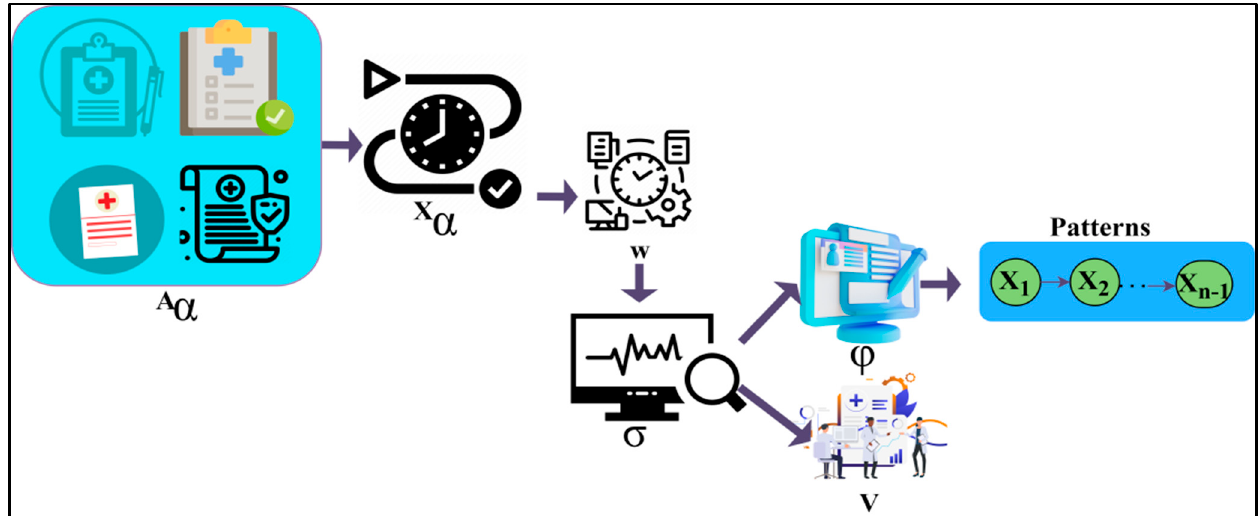
Figure 2. Schematic diagram of data recognition.